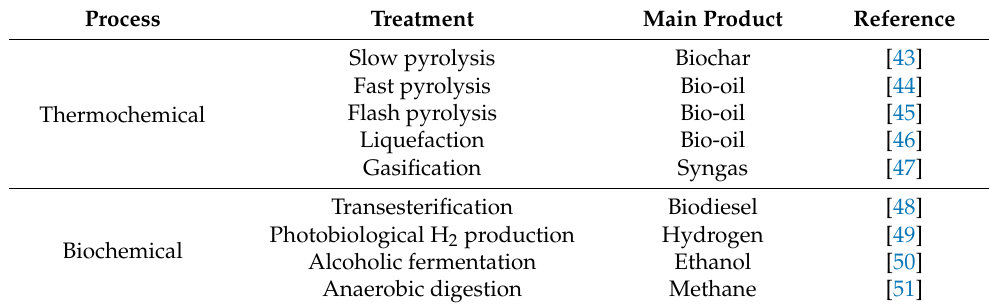
Table 1. Thermochemical and biochemical conversion of biomass and their specific products. Process Treatment Main Product Reference Slow pyrolysis Thermochemical